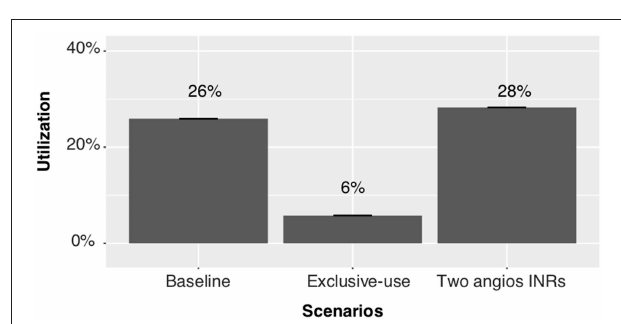
FIGURE 5 | A comparison of the utilization of angioINR by ECR patients under various